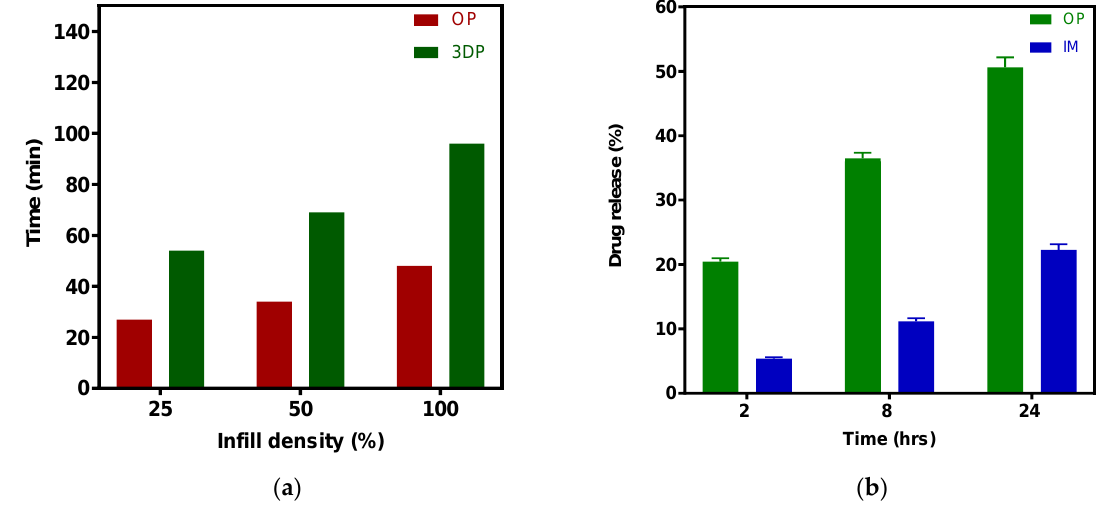
Figure 16. ( a ) Comparison of production efficiency (40 tablets per batch) between OP and 3DP; ( b ) Comparison of drug release profile between OP (25% infill) and IM.